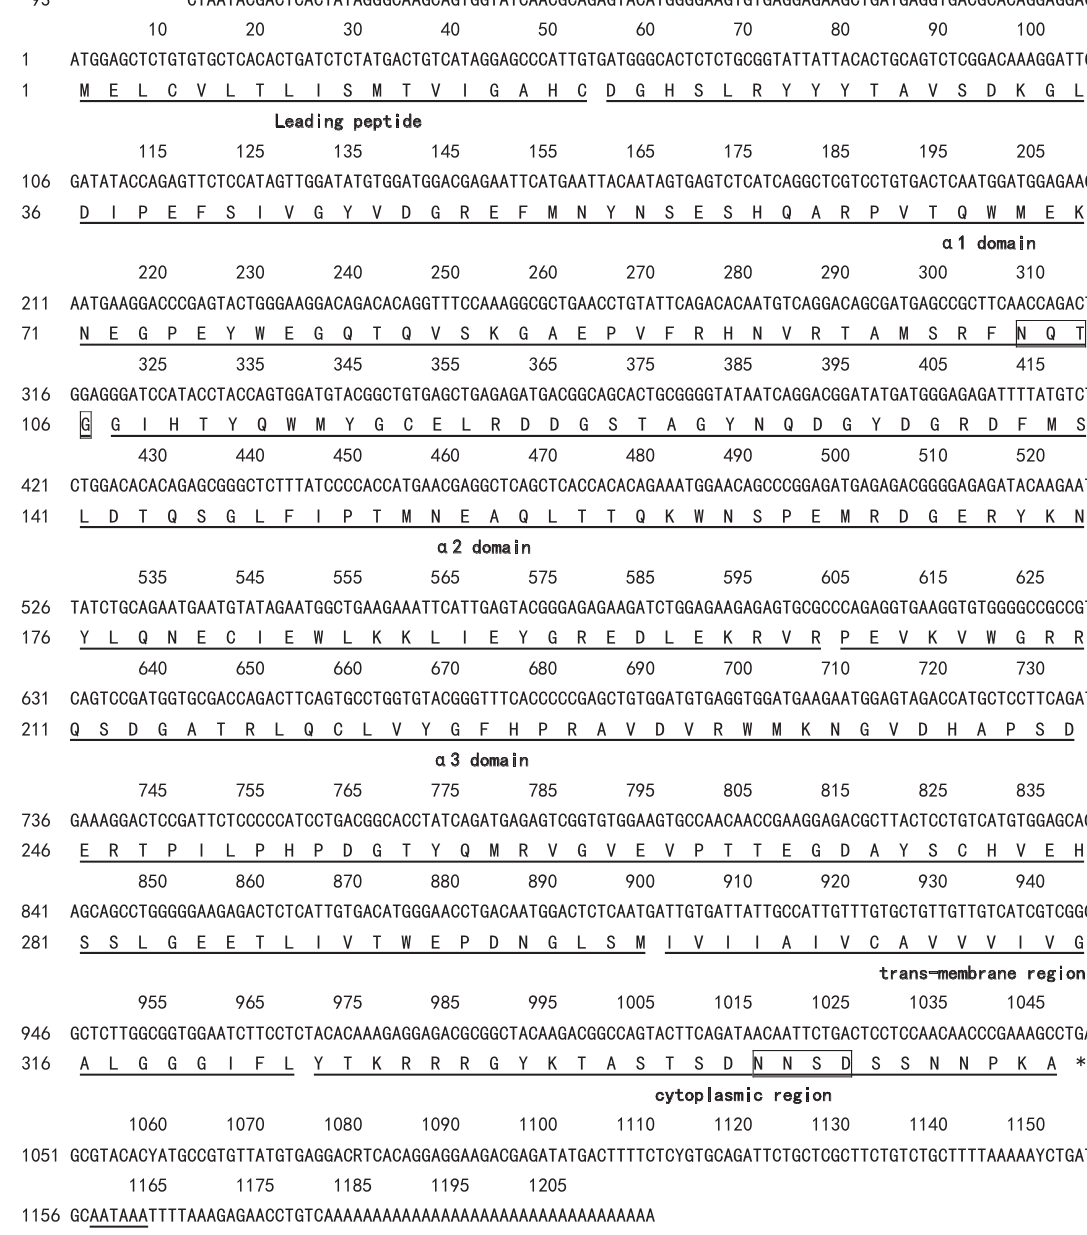
Figure 1. Nucleotide and predicted amino acid sequences of ZcMHC class Ia. The regions are marked by underline and the region name. The stop codon is indicated by an asterisk. N-glycosylation sites are marked with squares. The polyadenylation signal (AATAAA) is underlined in the 3 (cid:48)